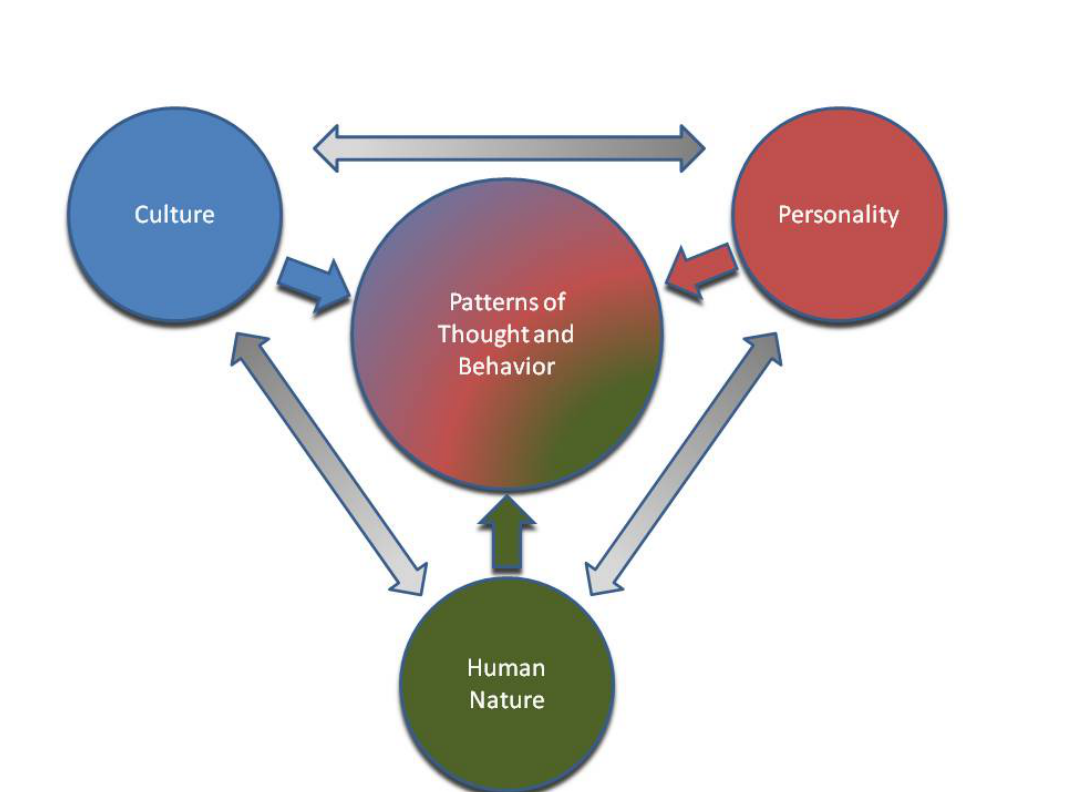
Figure 1 . Sources of thought and behavior and their